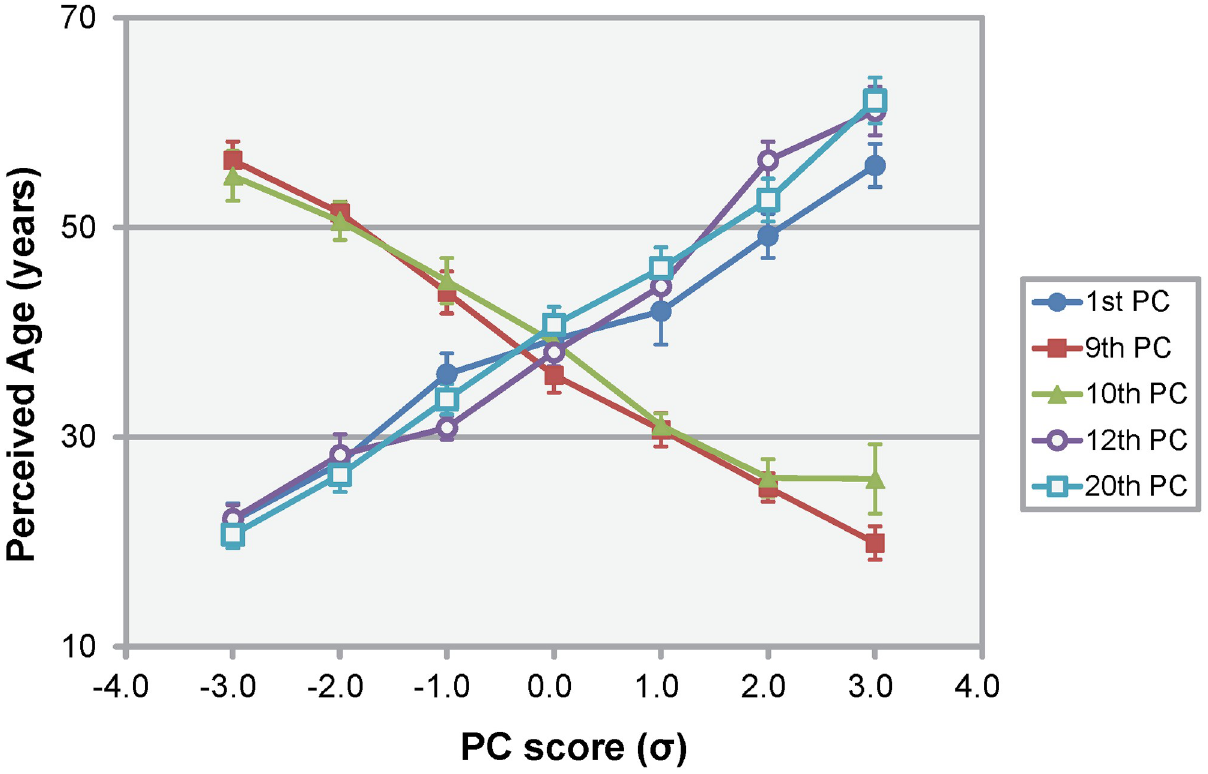
Fig 4. Relationship between the perceived ages of the simulated models a and the age-related principal component (PC) scores b . a Bars represent standard errors. b Each normalized PC score varied from –3.0 σ to +3.0 σ .